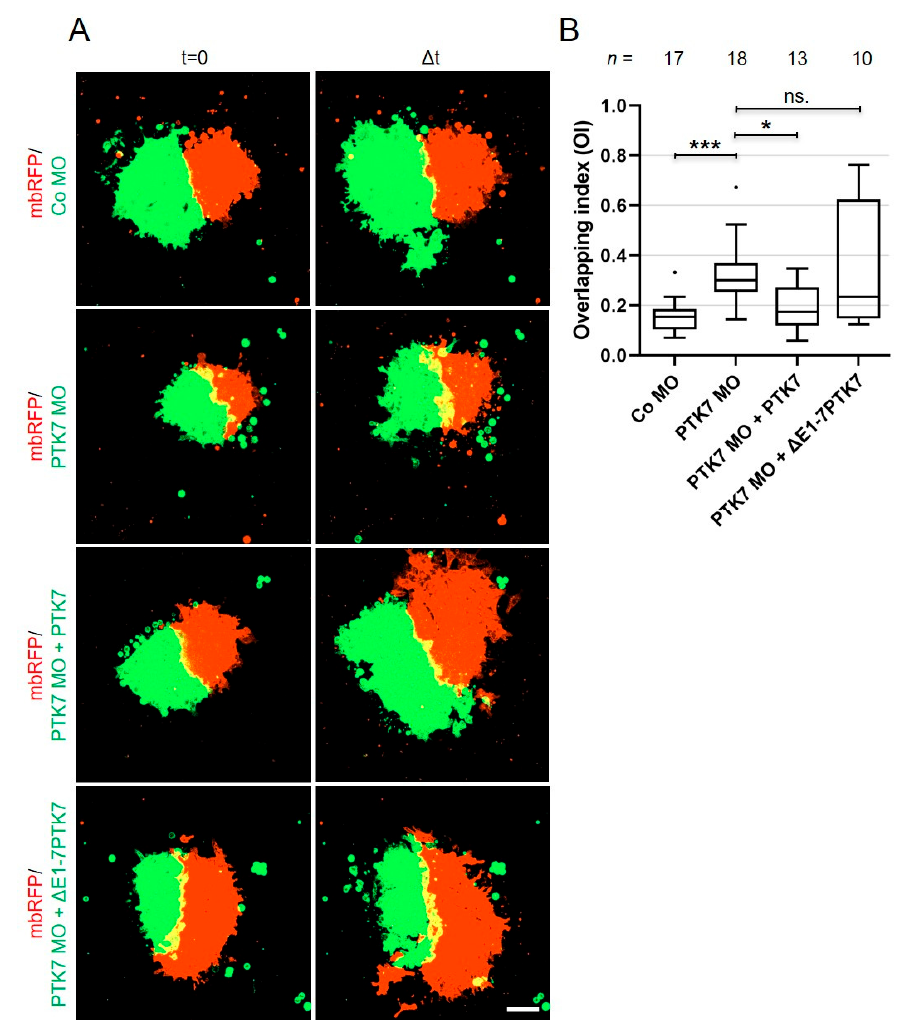
Figure 6. Loss of Ptk7 inhibits CIL in cranial NC explants. Confrontation assays were performed using explants injected with either 6.5 ng MO in combination with 100 pg mbGFP RNA or 200 pg mbRFP RNA as control. For rescue experiments 200 pg PTK7 or ∆ E1-7PTK7 RNA were co-injected with the MO. ( A ) First column: confronted explants at the start of the experiment (time point t = 0). Second column: confronted explants at the time point of the maximal invasion ( Δ t). Injected constructs are indicated for each condition on the left. The overlapping area is marked by yellow fluorescence. ( B ) Box plot showing overlapping indexes (OI) of the different NC explants with the control. The total number of analyzed confrontation events of at least three independent experiments is indicated for each column. The box extends from the 25th to the 75th percentile, with whiskers with maximum 1.5 IQR. The median is plotted as a line inside the box. * p < 0.05, *** p < 0.005, ns.: not significant (Kruskal–Wallis test).